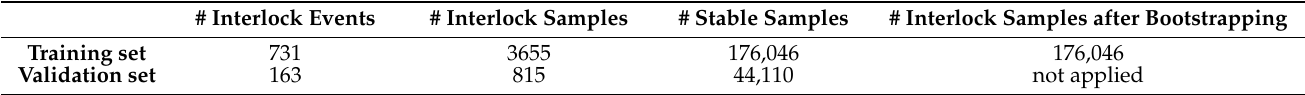
Table 3. Numbers of samples in the training and validation sets, before and after bootstrapping, where interlock samples are randomly drawn to have the same number as stable samples.